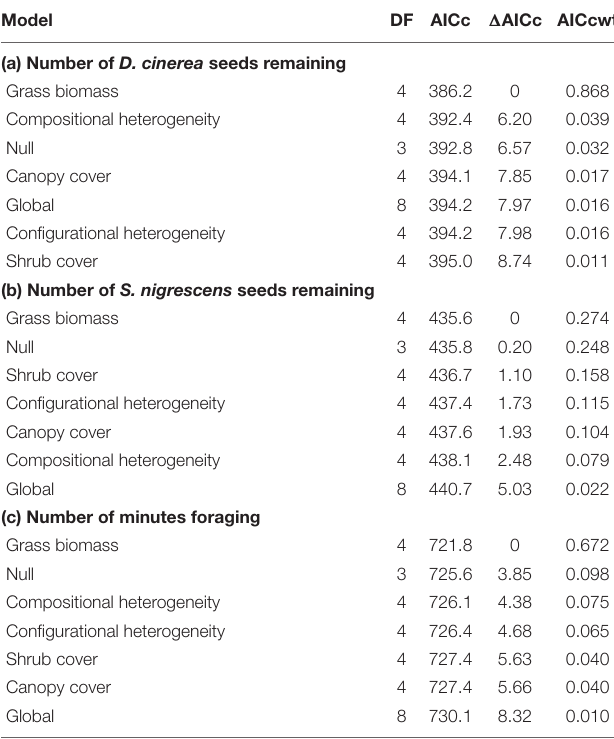
TABLE 1 | Degrees of freedom (DF), Akaike’s information criterion corrected for small sample size (AICc), difference in AIC scores ( (cid:49) AICc), and AICc weight (AICcwt) of models to explain differences in the numbers of Dichrostachys cinerea seeds remaining at seed trays (a), the number of Senegalia nigrescens seeds remaining at seed trays (b) and the total time (i.e., number of minutes) rodents foraged at each seed station